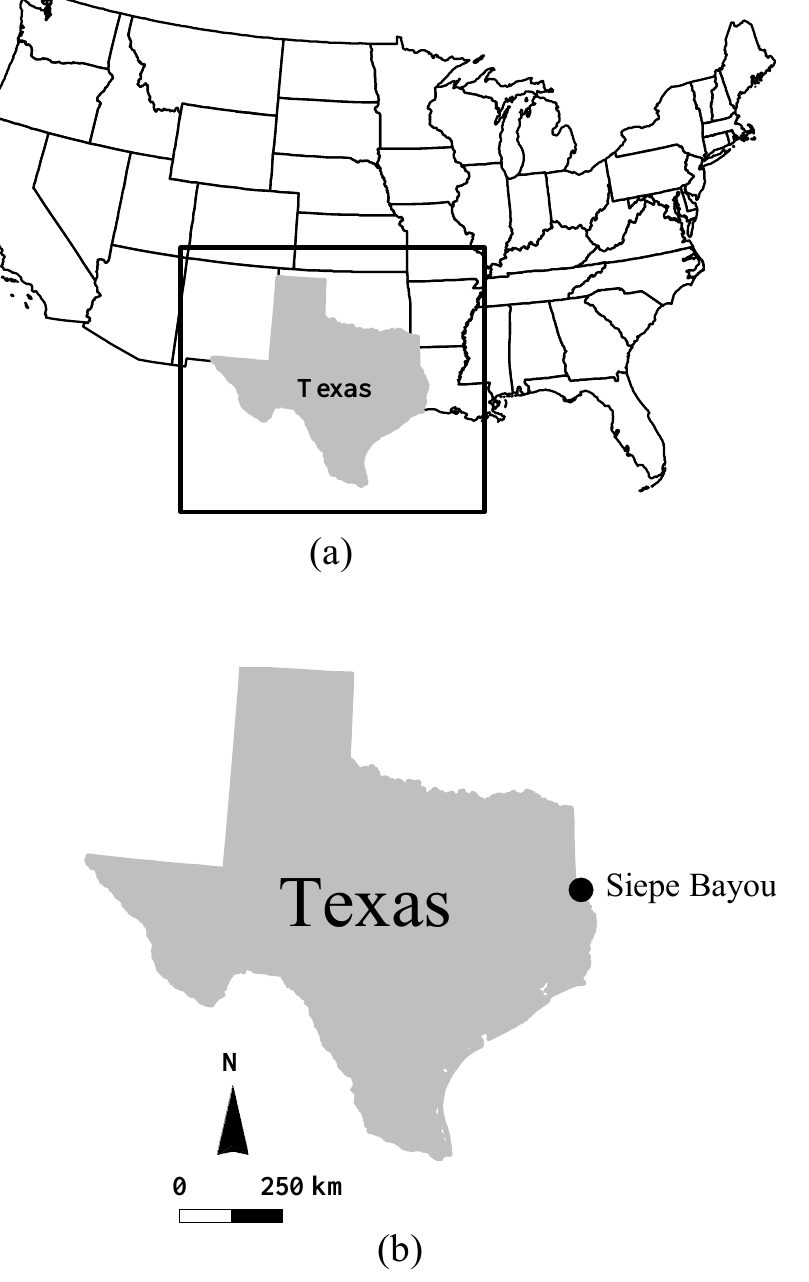
Figure 1. ( a) Map of the U.S. with the state of Texas highlighted in gray and (b) a map of Texas showing the location of the study